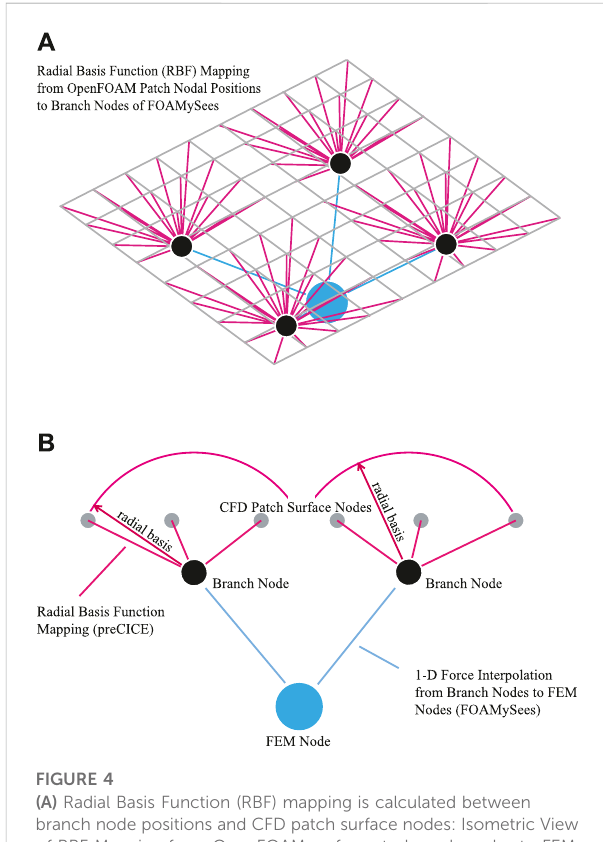
FIGURE 4 (A) Radial Basis Function (RBF) mapping is calculated between branch node positions and CFD patch surface nodes: Isometric View of RBF Mapping from OpenFOAM surfaces to branch nodes to FEM nodes, (B) Elevation View of RBF Mapping from OpenFOAM surfaces to branch nodes to FEM